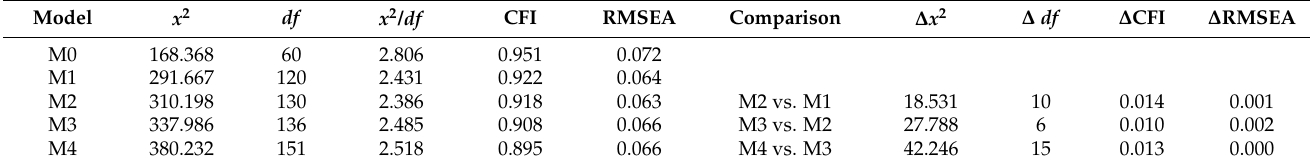
Table 2. Model fit of CRIES-13.